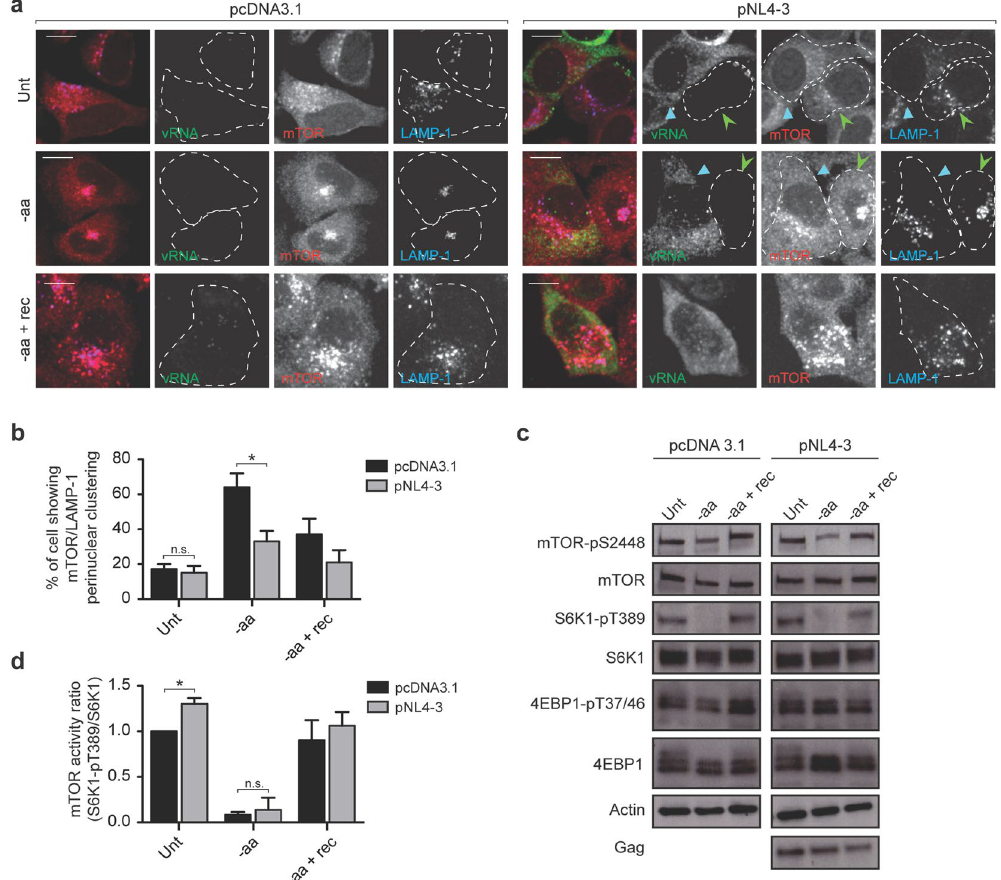
Figure 3. HIV-1 does not maintain mTORC1 activation during nutrient deprivation. ( a ) HeLa cells were transfected with either pcDNA3.1 or pNL4-3 and starved for amino acids (aa) (and serum) (1 h) and subsequently recovered with complete media (serum free) for an additional 30 minutes. HIV-1-expressing cells were identified by viral RNA (vRNA) using fluorescence in situ hybridization (FISH) and were stained with antibodies against the lysosomal population of mTOR (Cell Signaling 7C10) and LAMP-1. Light-blue arrowheads identify HIV-1-expressing cells, while HIV-1-negative cells in the same field are indicated with green arrowheads. A dashed line contours individual cells. Scale bars are 10 μ m. ( b ) The percentage of mock or HIV-1-transfected cells showing perinuclear clustering of mTOR/LAMP-1 from panel a. The results are presented as the mean ± S.D. from three different experiments. P value is indicated by * (p < 0.05). ( c ) HeLa cells were transfected with either pcDNA3.1 or pNL4-3 and starved for amino acids (aa) (1 h) and subsequently recovered with complete media for an additional 30 minutes. Cell lysates were subjected to SDS-PAGE, immunoblotted and probed with the indicated antibodies. Full-length blots are shown in Supplementary Fig. 5. ( d ) The graphs show the ratio of S6K1-pT389/total S6K1 for mock or HIV-1-transfected cells as in panel c. Values were normalized against untreated cells transfected with pcDNA3.1. The results are presented as the mean ± S.D. from three different experiments. P value is indicated by * (p < 0.05); n.s.: no signifcant difference between the